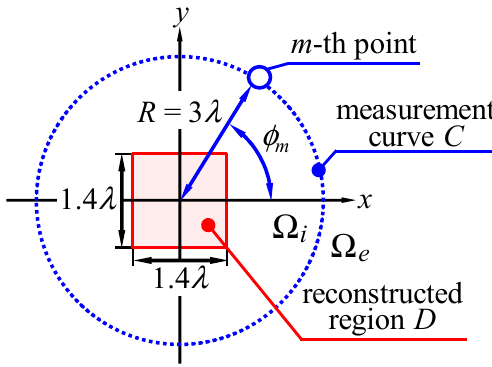
Figure 3. Geometrical configuration of the inverse scattering problem.